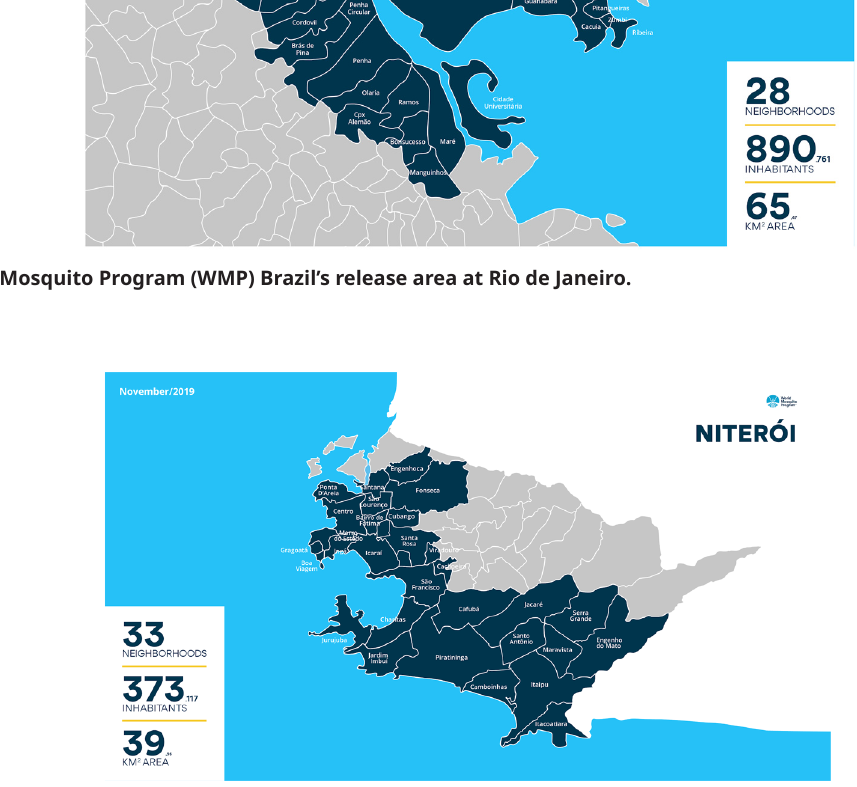
Figure 3. World Mosquito Program (WMP) Brazil’s release area at Niterói.